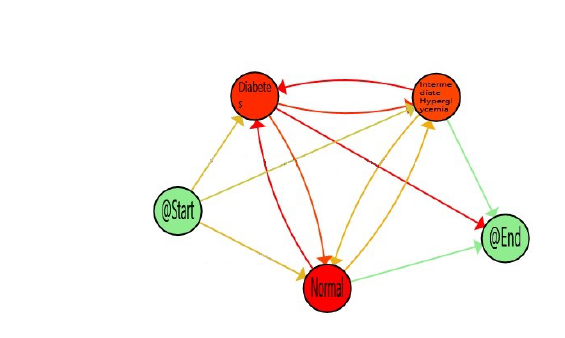
Figure 6. Dynamic fasting plasma glucose (FPG) for elderly